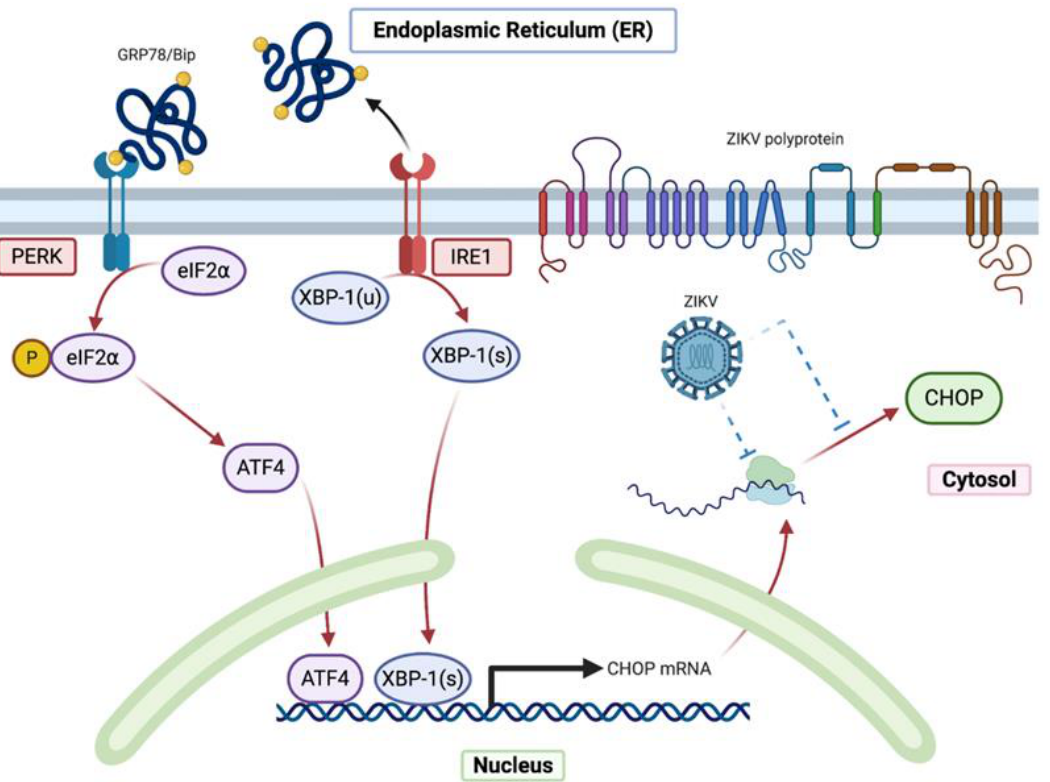
Figure 6. Graphical overview of the impaired expression of CHOP during ZIKV infection. Supplementary Materials: The following are available online at https://www.mdpi.com/article/10 .3390/ijms22073750/s1, Figure S1: Immunofluorescence detection of ZIKV envelope (ZIKV-E,DIII, green) expressing cells and CHOP protein (red) in HuH7 cells infected or not with ZIKV-MR766 at MOI = 5 for 24h, further treated or not with TG and treated or not with Bortezomib for 4 h at 20 h.p.i. CHOP nuclear localization was controlled with the panel of cells treated with TG for 4 h. Nuclei were stained with DAPI (blue). h.p.i: hours post-infection, Figure S2: Immunofluorescence detection of ZIKV envelope (ZIKV-E,DIII, green) expressing cells and CHOP protein (red) in HuH7 cells infected or not with ZIKV-MR766 at MOI = 5 for 24 h, further treated or not with TG and treated or not with Bortezomib for 4 h at 20 h.p.i. CHOP nuclear localization was controlled with the panel of cells treated with TG for 4 h. Nuclei were stained with DAPI (blue). h.p.i: hours post-infection.